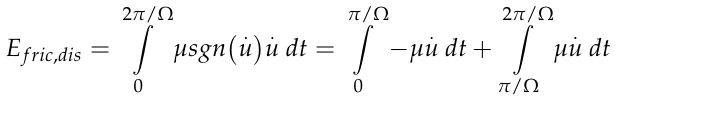
Figure 7. Comparison of frequency-response curves when varying the inertia (cid:1836) ( (cid:2009) ∗ = 0.1(cid:2033) (cid:2868)(cid:2870) , (cid:1856) ∗ = 0.075(cid:2033) (cid:2868) , (cid:2020) ∗ = 0.01(cid:2033) (cid:2868)(cid:2871) , (cid:2033) (cid:2868) = 1, (cid:2030) (cid:3036),(cid:3037) (cid:1869)(cid:3548) = 0.15 ).